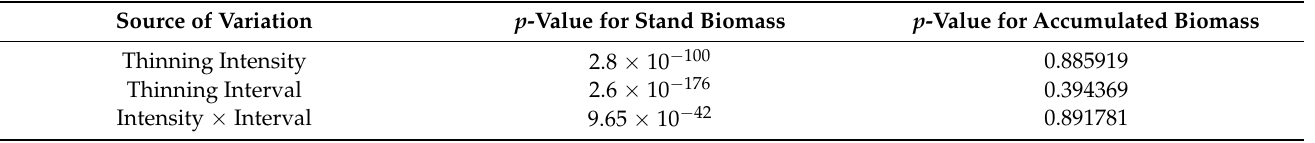
Table 2. Summary of two-way ANOVA test for stand and accumulated biomass. Source of Variation p -Value for Stand Biomass p -Value for Accumulated Biomass Thinning